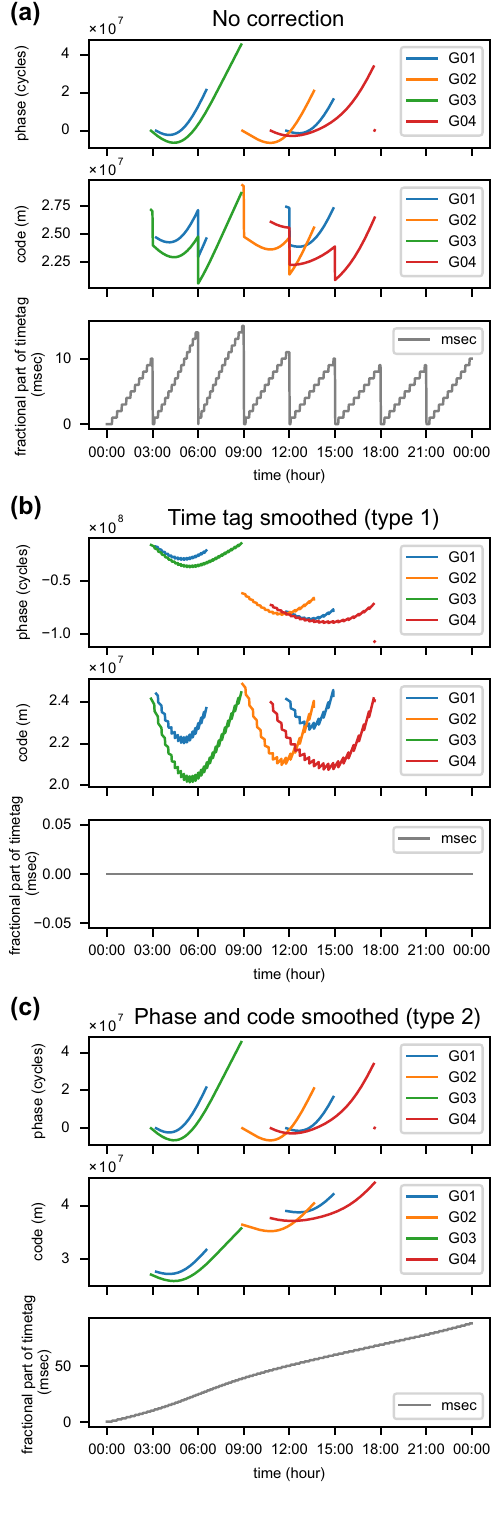
Fig. 3 Examples of clock jump corrections. a no correction, b time tag smoothed, and c code and phase smoothed. The top, middle, and bottom panels show phase and code pseudoranges, and millisecond part of time tag, respectively. The observation data of IGS site AIRA (January 1, 2001) are shown